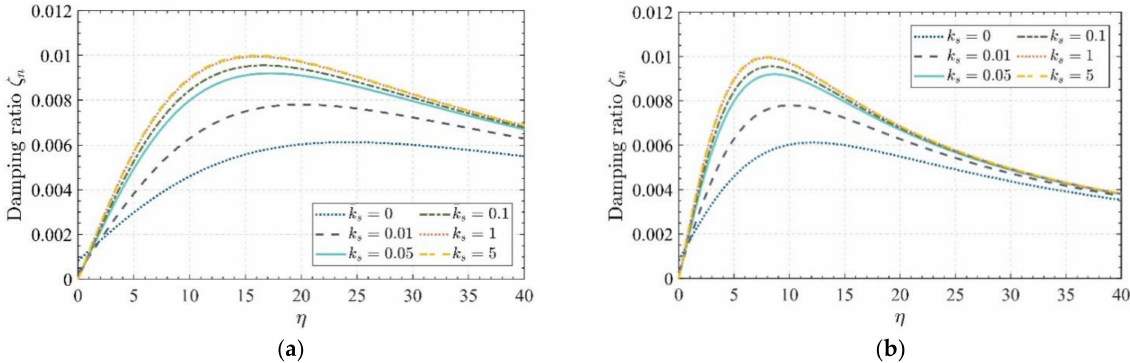
Figure 6. Impact of support flexibility of the internal rubber damper on cable modal damping with K = 300, ϕ = 0.5, x 1 / L = 0.01, x 2 / L = 0.02 and: ( a ) n = 1; ( b ) n = 2.